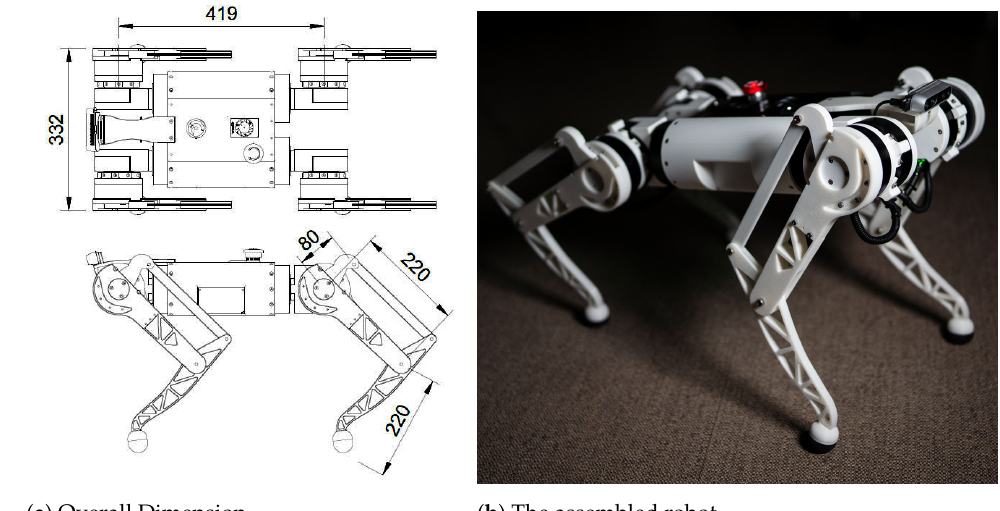
Figure 1. The PADWQ